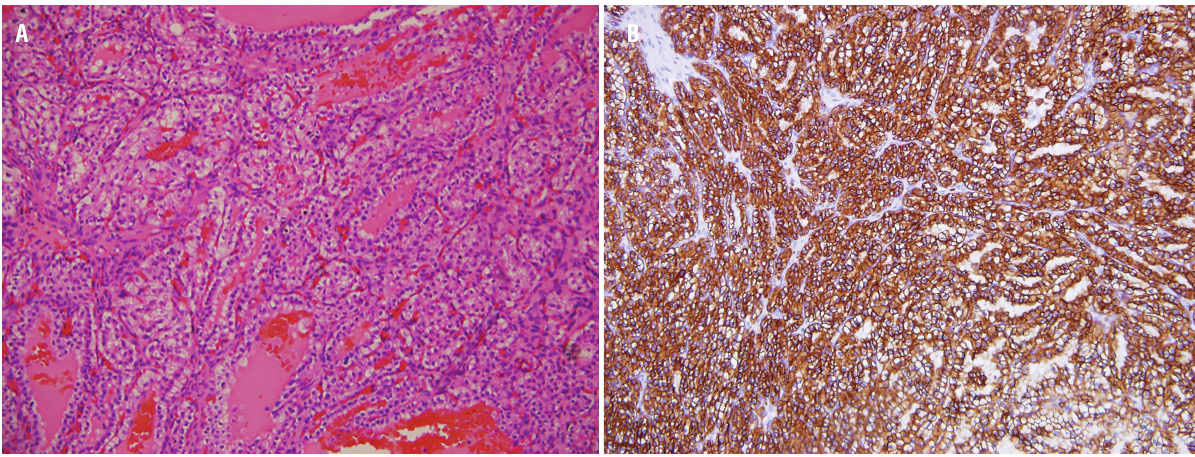
Figure 2 - Light micrograph of a histologic specimen of human